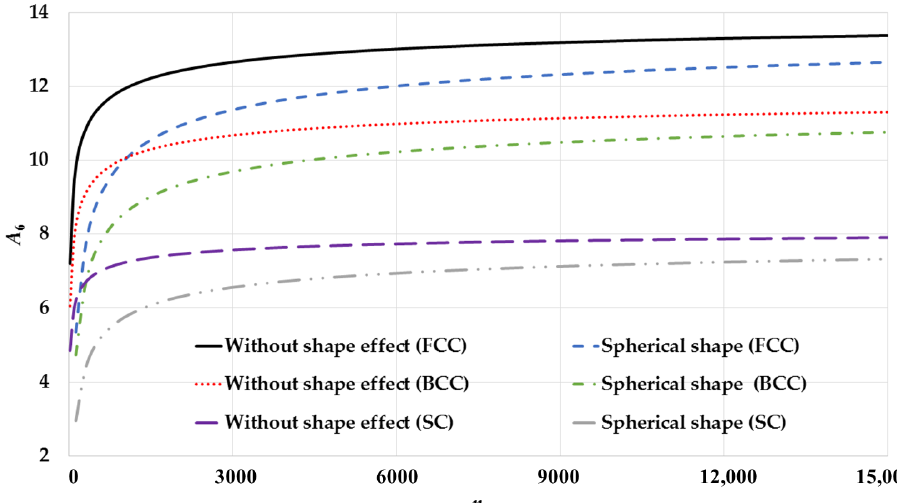
Figure 1. Size-dependent of the potential parameter 𝐴 6 as function of 𝑛 of spherical nanoparticles in different cubic structures: SC, BCC, and FCC and compared to without shape effect case that is based on Qi et al. model [34].